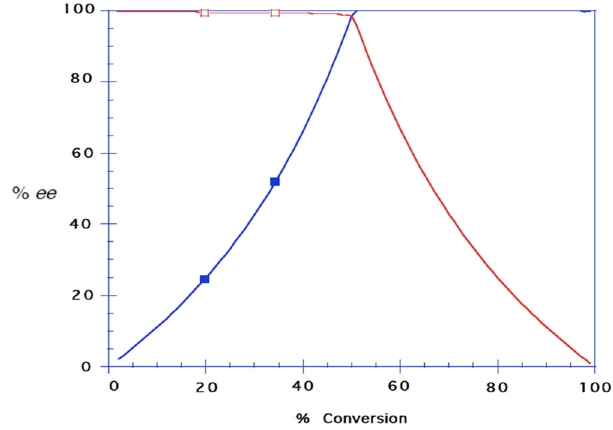
Figure 3. Reaction progress of kinetic resolution of 8 with CALB in dry hexane with vinyl butanoate as acyl donor, E ≥ 200. Both the butanoate ester enantiomer of 8 , ( R )- 9 and the remaining alcohol ( S )- 8 were obtained in 99% ee . Chiral GLC and HPLC analyses gave ee s - and ee p -values from which the degree of conversion was calculated according to c = ee s /( ee s + ee p ).